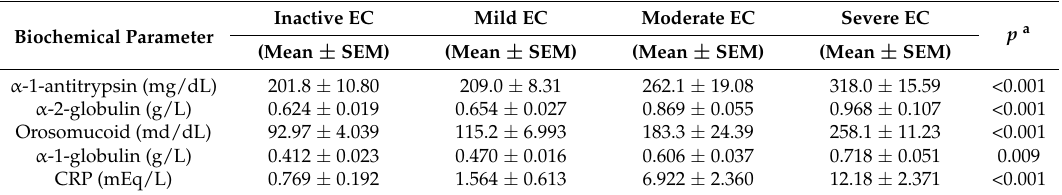
Table 5. Plasma inflammatory biomarker levels of CD patients as a function of severity.